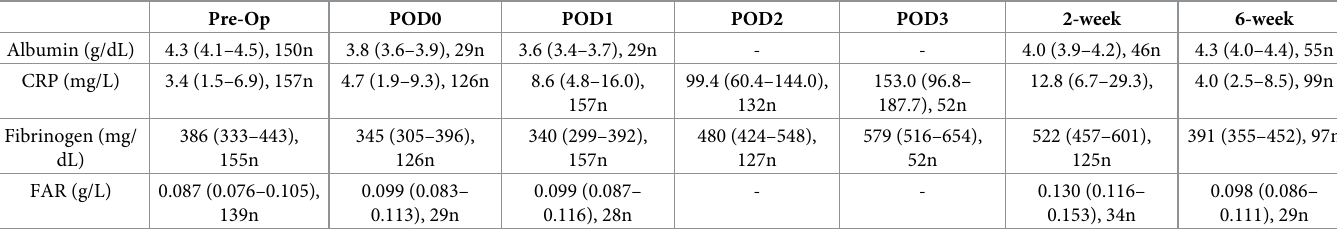
Correlation The correlation coefficient between the postoperative course of albumin and CRP was -0.41, while the correlation coefficient between the postoperative course of albumin and fibrinogen Table 2. Circulating acute phase reactants following